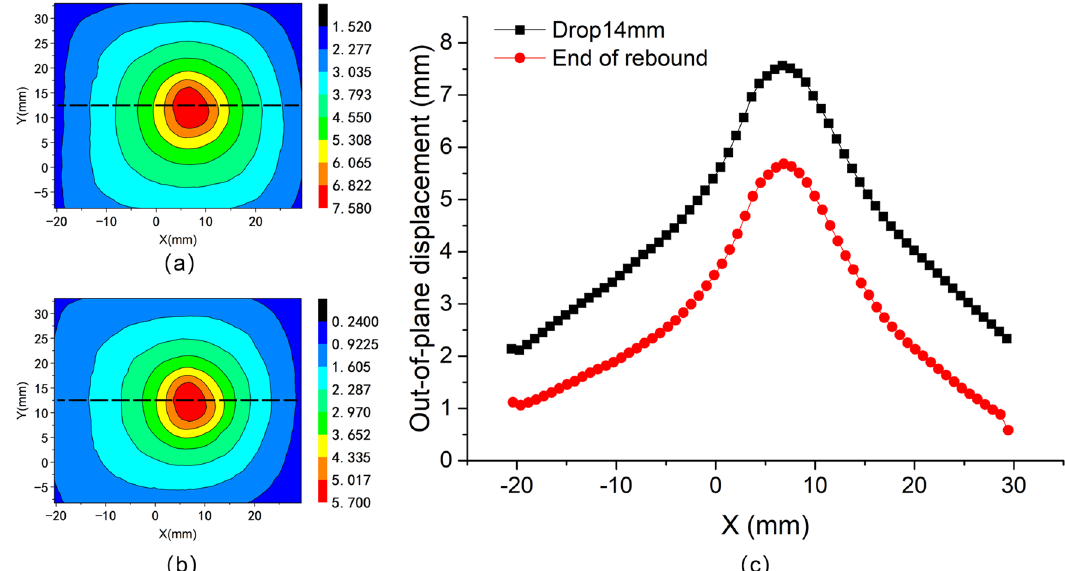
Figure 3: Out - of plane displacements of two moments when drop distance was 14 mm: ( a ) contours at the end of loading, ( b ) contours at the end of rebound, and ( c ) comparison between the displacements of center